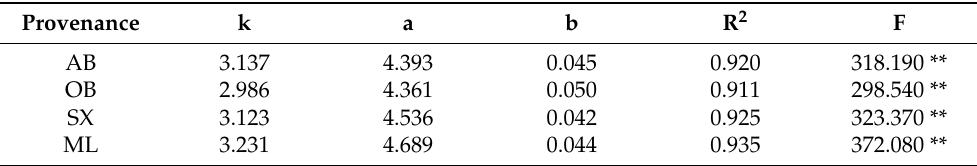
Table 7. Estimated parameters of logistic curve of seedling ground diameter of X. sorbifolium from different provenances.